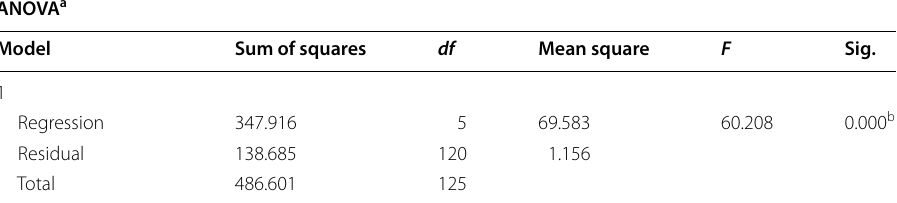
a Dependent variable: